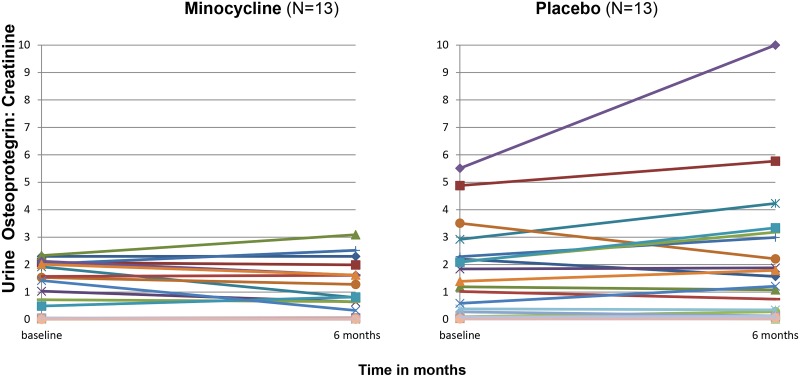
Spaghetti plots of the urine osteoprotegerin: Creatinine measurements of each patient in the study from baseline to 6 months (end of trial).Baseline urine values were not available for 3 subjects.